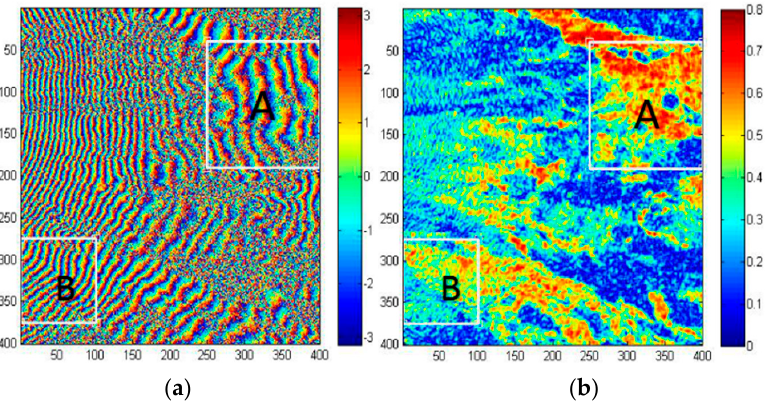
Figure 7. ( a ) Interferometric phase; and ( b ) corresponding coherence map over Mt Etna Volcano, Italy. A and B, labeled by white rectangles, indicates the enlarged areas.